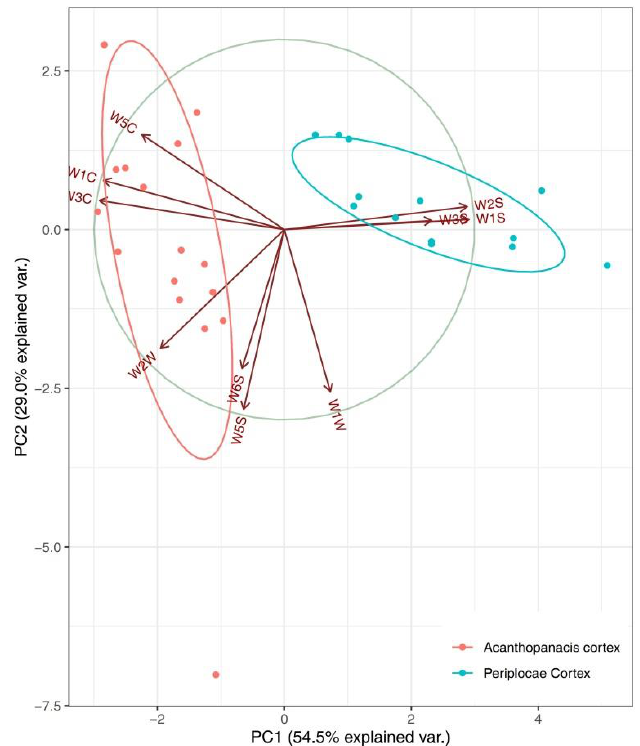
Figure 3. RDA biplot displaying the relationship between sample odor and E-nose sensors.